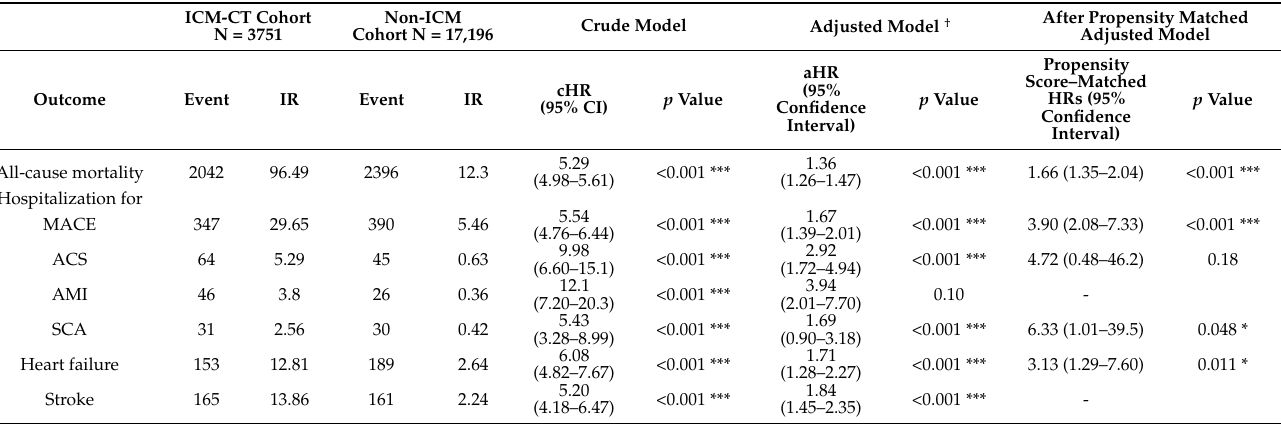
Table 2. Incidence and hazard ratios of all-cause mortality and MACEs in patients with ICM-CT exposures compared to those without, by type of